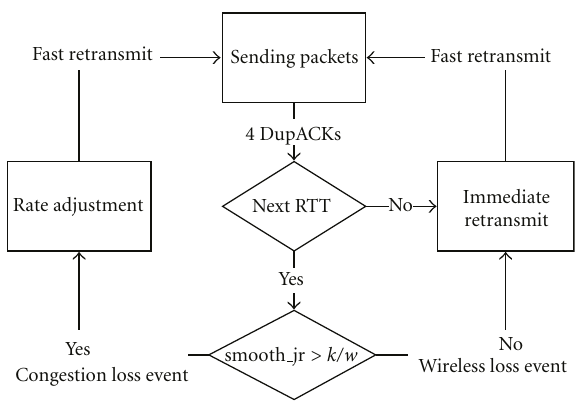
Figure 4: Flow chart of JSCTP when four DupSACKs occurred.